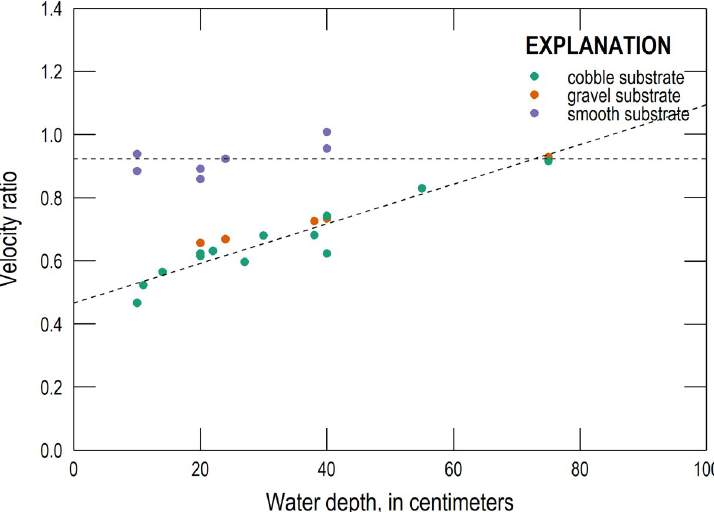
Fig 3. Velocity ratio versus water depth for all conditions. The horizontal dashed line shows the average velocity ratio of 0.92 for the smooth substrate; the second dashed line is the line of best fit between velocity ratio and water depth for the gravel and cobble substrates.